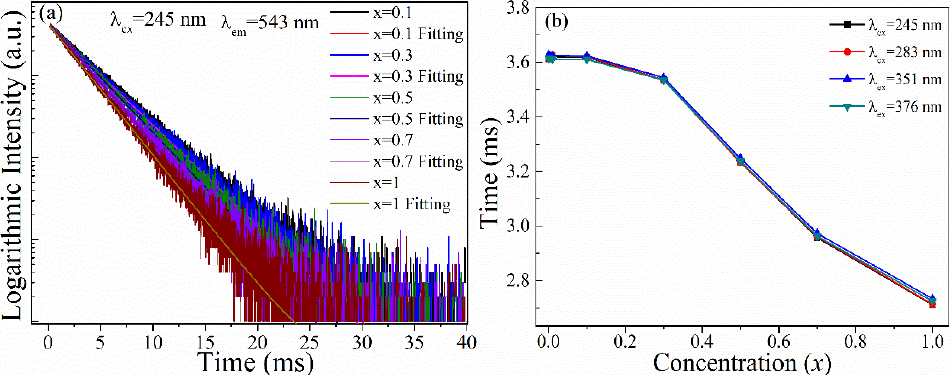
Figure 5. Decay curves ( a ) and energy level lifetimes ( b ) of KYC: x Tb